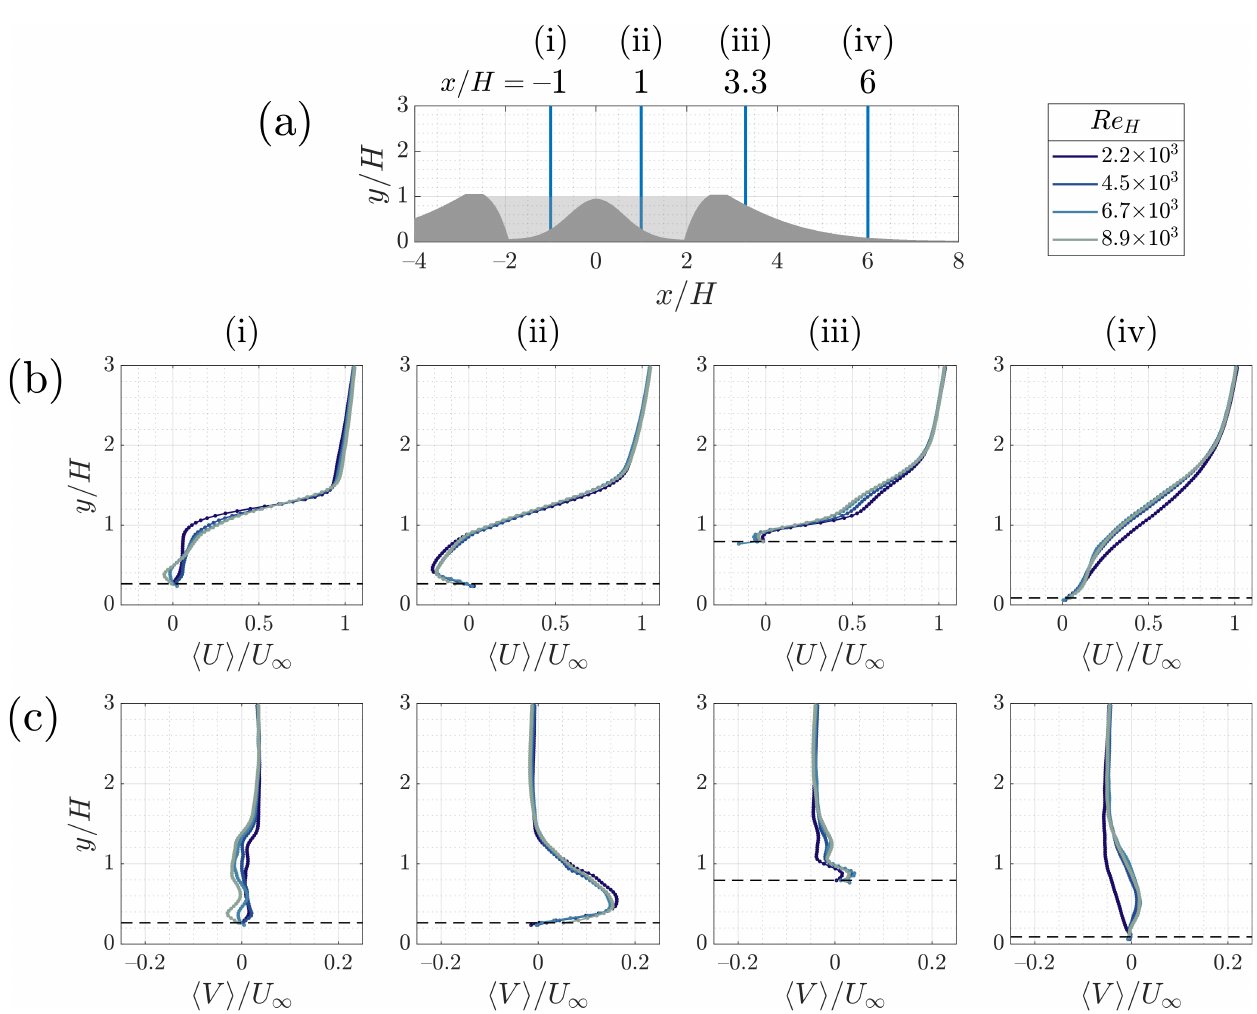
Figure 5. Profiles of normalized mean velocity components along the crater centerline for four different Re . Data are normalized by the free-stream velocity, U ∞ . ( a ) A reference of the streamwise locations of the profiles. The four streamwise locations from which data were extracted: x / H = ( i ) − 1, ( ii ) 1, ( iii ) 3.3, and ( iv ) 6; ( b ) streamwise component, (cid:104) U (cid:105) ; ( c ) wall-normal component, (cid:104) V (cid:105) . The horizontal dashed lines in ( b , c ) demarcate the elevations of the model’s surface at the corresponding x / H = profile